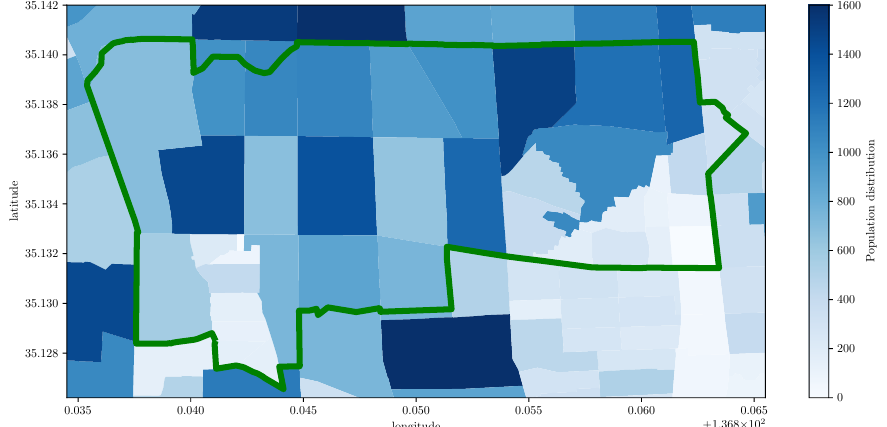
Figure 3. Geographical distribution of residents [persons] in Arako district covered by the green polygon (2.7 [km] 1.9 ×